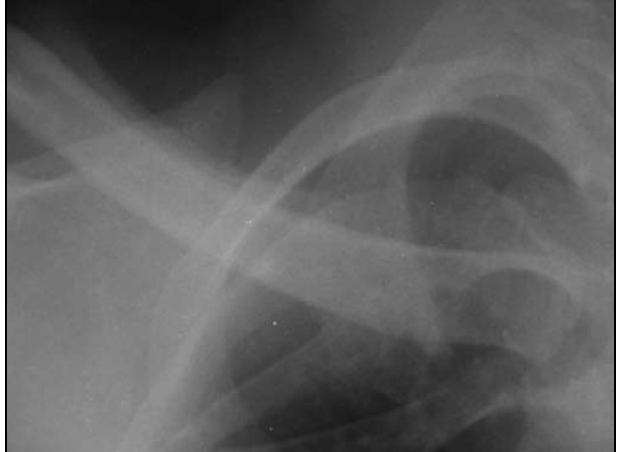
Fig. 2. Cropped section of chest radiograph showing abnormal rib splitting.